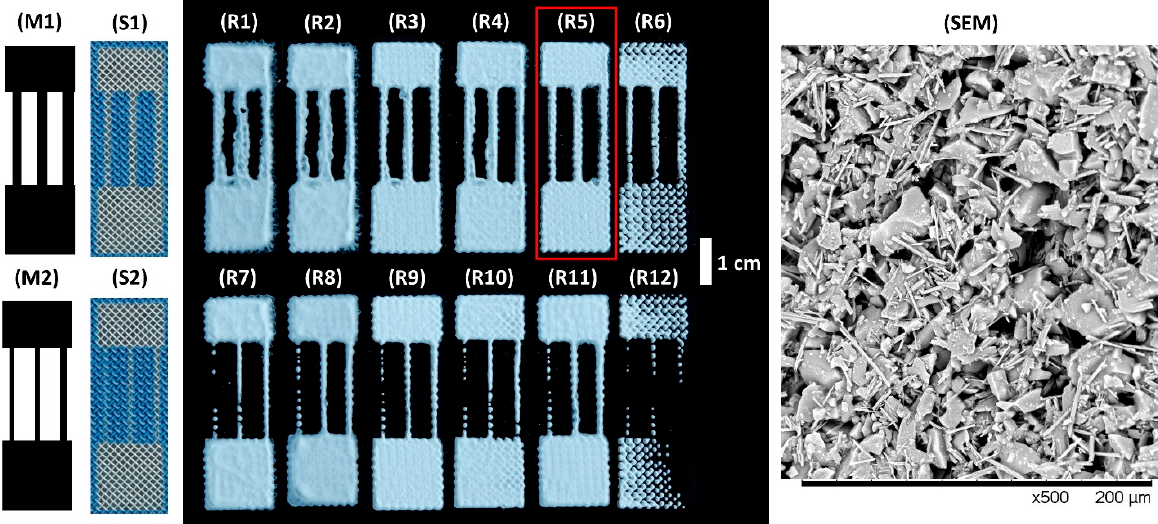
Figure 3. Masks used for preparing the stencil on the SP screen ( M1 and M2 ), the corresponding stencils prepared on the screen ( S1 and S2 ), the results of screen printing with different concentrations of the TLC mixture ( R1 – R12 ), and SEM micrograph of the silica gel microparticles and gypsum mixture. Widths of channels on mask ( M1 ) from left to right are as follows: 1.8 mm, 2.1 mm and 2.4 mm. Widths of channels on mask ( M2 ) from left to right are as follows: 0.9 mm, 1.2 mm, 1.5 mm. The length of the channels was 2 cm and the length of the whole shape was 4.5 cm. The width of each shape was 1.5 cm. In both rows the slurry concentration increases from left to right, as follows: 0.35, 0.40, 0.43, 0.47, 0.51, 0.57 g/mL. The conditions used for print ( R5 ), highlighted with the red box, were found to be optimal.